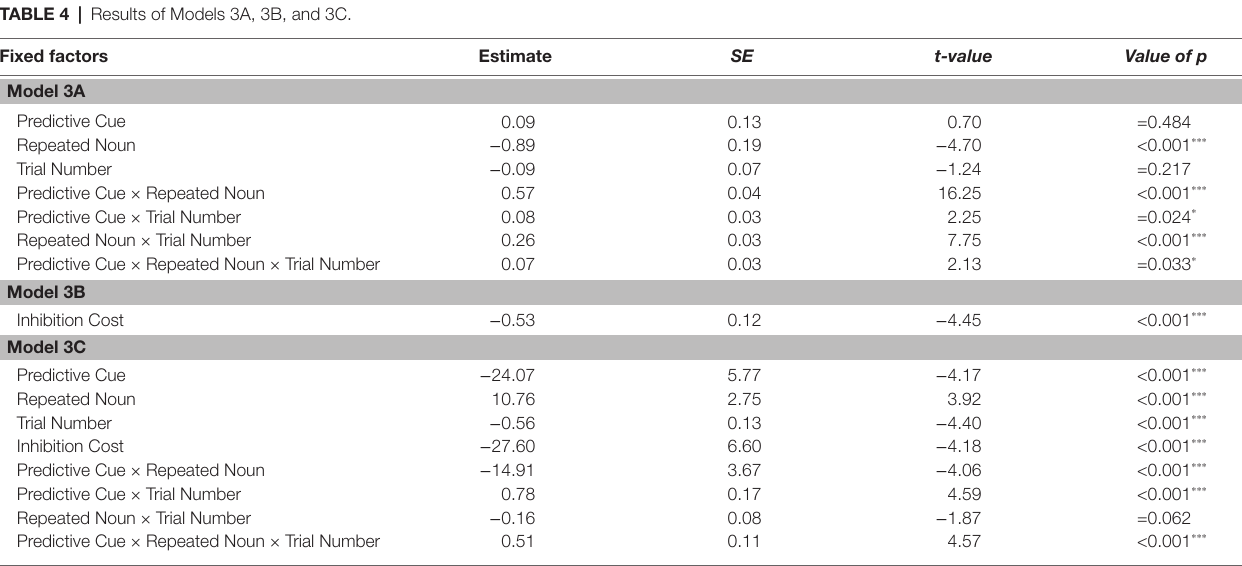
TABLE 4 | Results of Models 3A, 3B, and